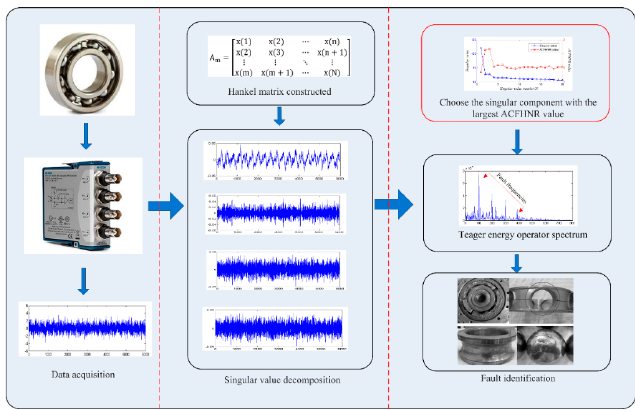
Figure 3. The framework of the proposed method.